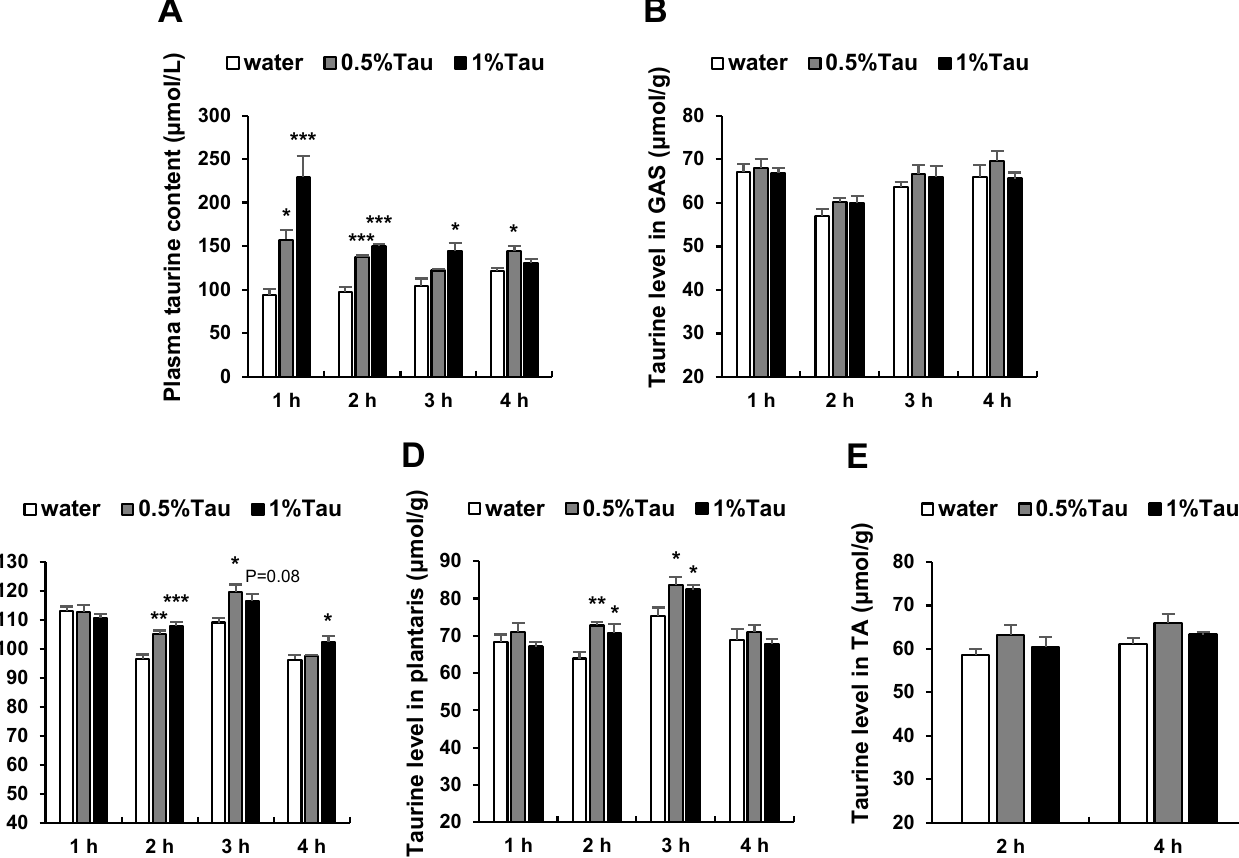
Figure 1. Effects of short-term taurine supplementation on taurine levels in the plasma and skeletal muscles of rats. Taurine (Tau) groups of 0.5% and 1% were orally administered taurine at 0.5% (25 mg taurine /kg body weight [BW]) and 1% (50 mg taurine/kg BW), respectively, for 10 d, and the taurine levels in plasma and skeletal muscles were measured 1–4 h after the administration of taurine on the 10th day in rats at 14 weeks of age. ( A ) Taurine level in plasma ( µ mol/L). ( B ) Taurine level in gastrocnemius (GAS) muscle ( µ mol/g). ( C ) Taurine level in soleus muscle ( µ mol/g). ( D ) Taurine level in plantaris muscle ( µ mol/g). ( E ) Taurine level in the tibialis anterior (TA) muscle ( µ mol/g). Values shown represent the mean ± standard error (SE) (n = 3–6). * p < 0.05, ** p < 0.01, *** p < 0.001, statistically significant vs. the value of water group. Results were analyzed using Dunnett’s test.